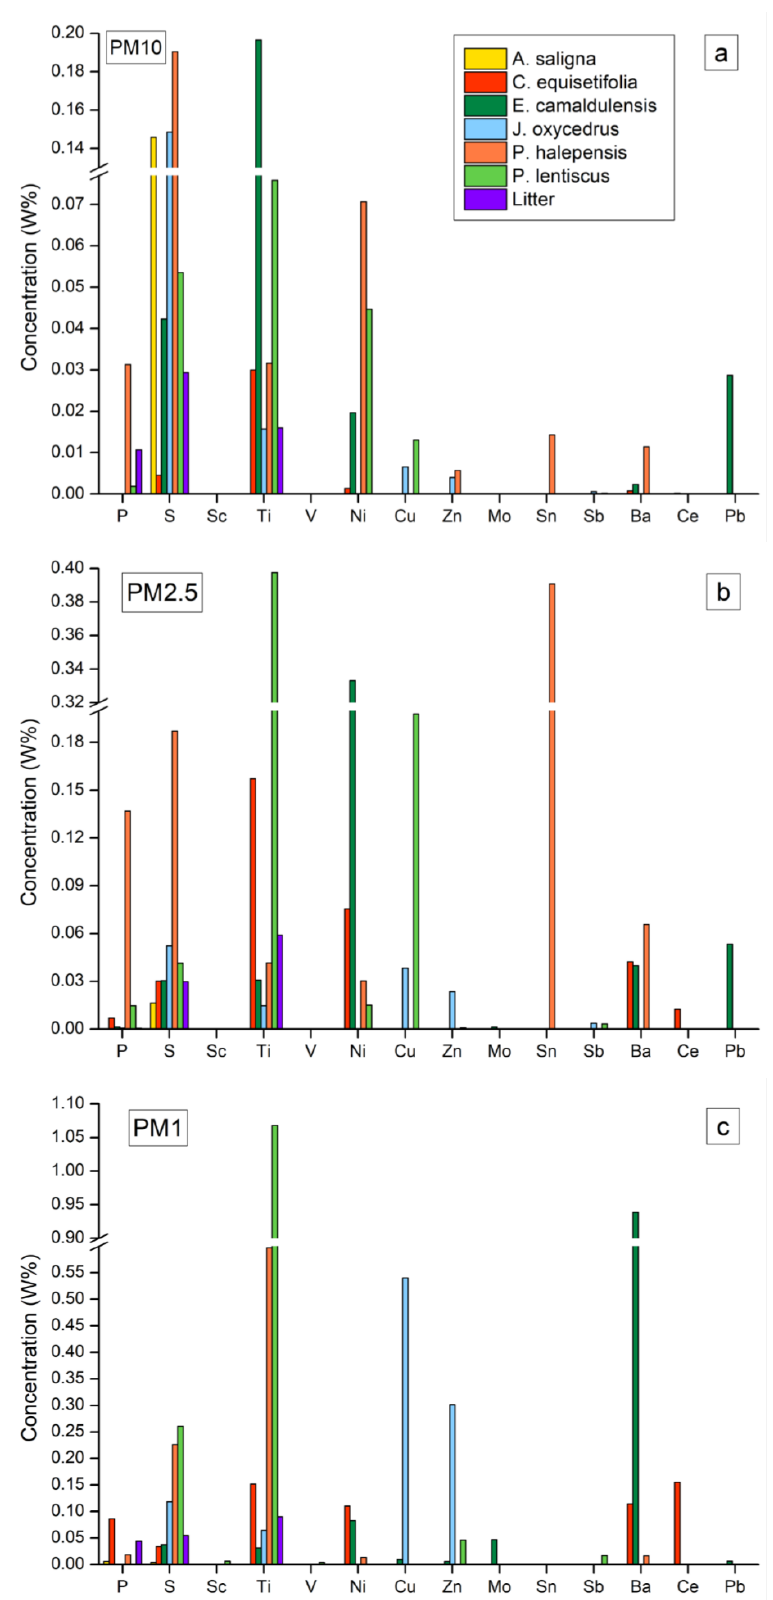
Figure 4. Weighted volume percentages (W%) of the trace elements estimated from SEM/EDX analysis for different species and litter are shown for PM10 ( a ), PM2.5 ( b ) and PM1 ( c ).